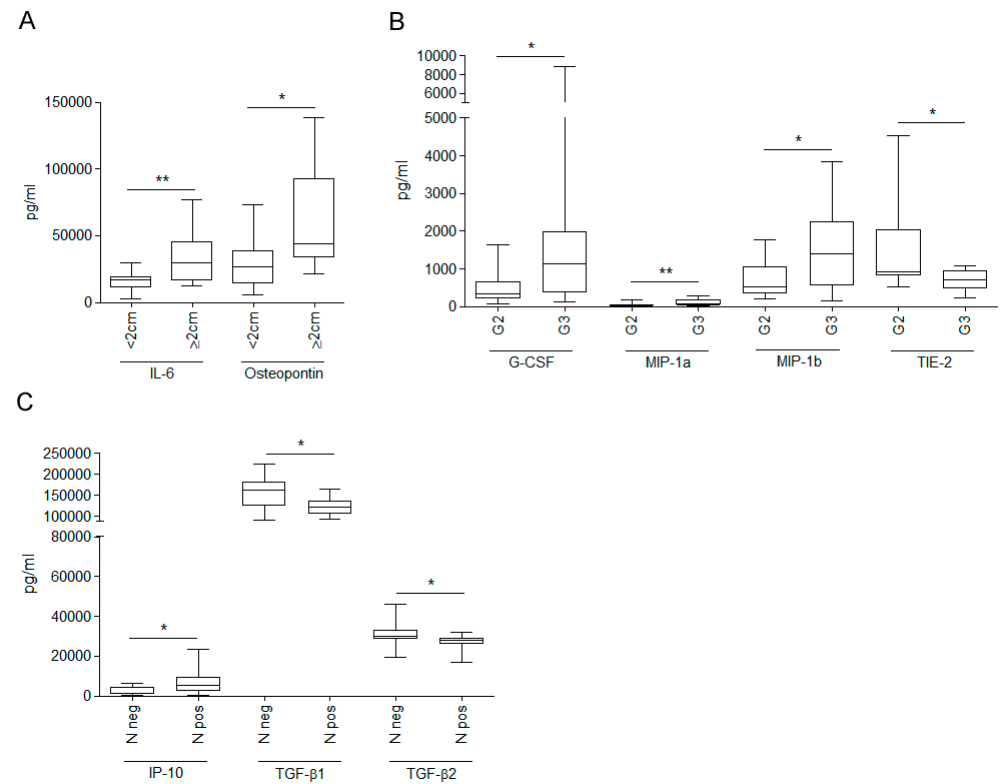
Figure 3. Differences in small-molecule composition of wound healing fluid from breast carcinoma surgery according to tumor size, tumor grade, and lymph node positivity. Concentration (pg/mL) of 34 molecules, including cytokines, chemokines, and growth factors (listed in Material and Methods), was assessed by Bio-plex assay in 27 wound healing fluids from breast cancer patients. Levels of small molecules were differentially enriched by breast cancer size ( A ), tumor grade (grade II (G2); grade III (G3) ( B ), and lymph node ( C ) (* p -value ≤ 0.05; ** p -value ≤ 0.01; Mann–Whitney test).